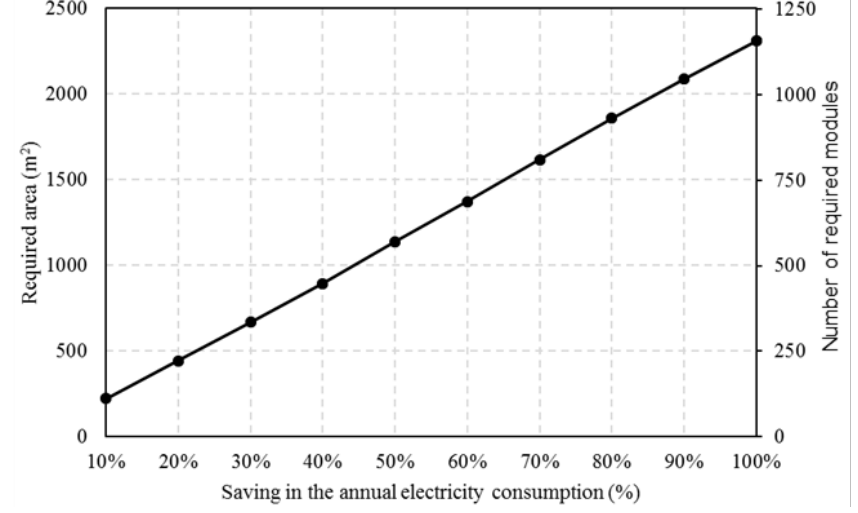
Figure 7. The required area vs. the saving target in the annual electricity consumptions of the case study.